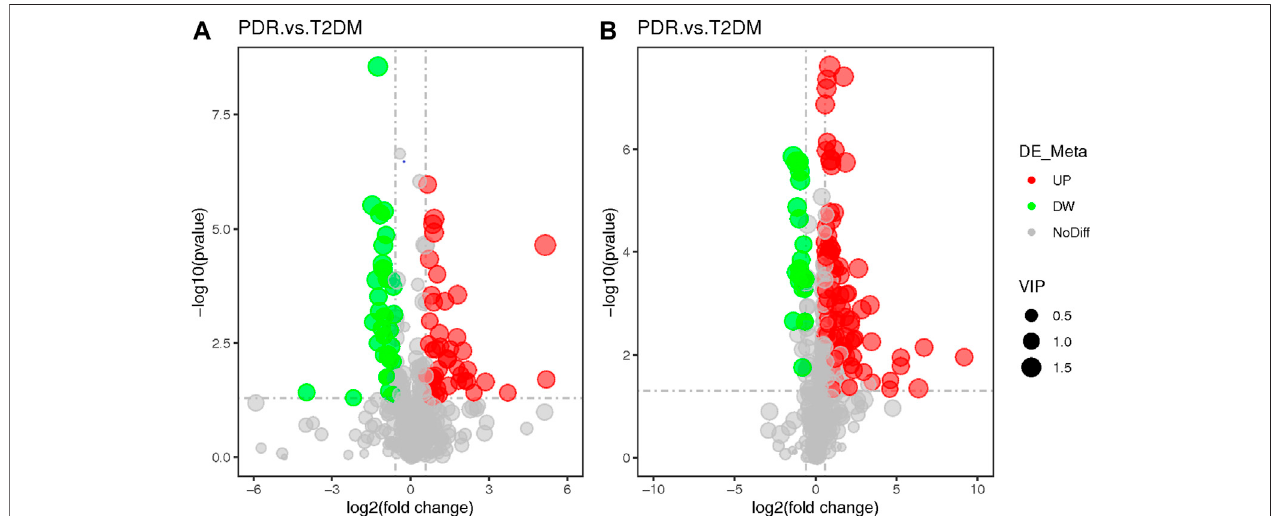
FIGURE 7 | (A) Positive mode. (B) Negative mode. The volcano map of the log2 (FC) and − log10 ( p -value) showed that 259 features were signi fi cantly different betweenPDR patients ( n =15) andT2DM patients( n =15).Signi fi cantmetabolic features thatincreased(reddots) ordecreased(green dots) inPDR patients compared with T2DM patients are indicated with dot size representing the VIP value. In the positive mode, compared with T2DM patients, 39 metabolic features were signi fi cantly increased and 24 metabolic features were signi fi cantly decreased in PDR patients. In the negative mode, compared with T2DM patients, there were 82 metabolic features.